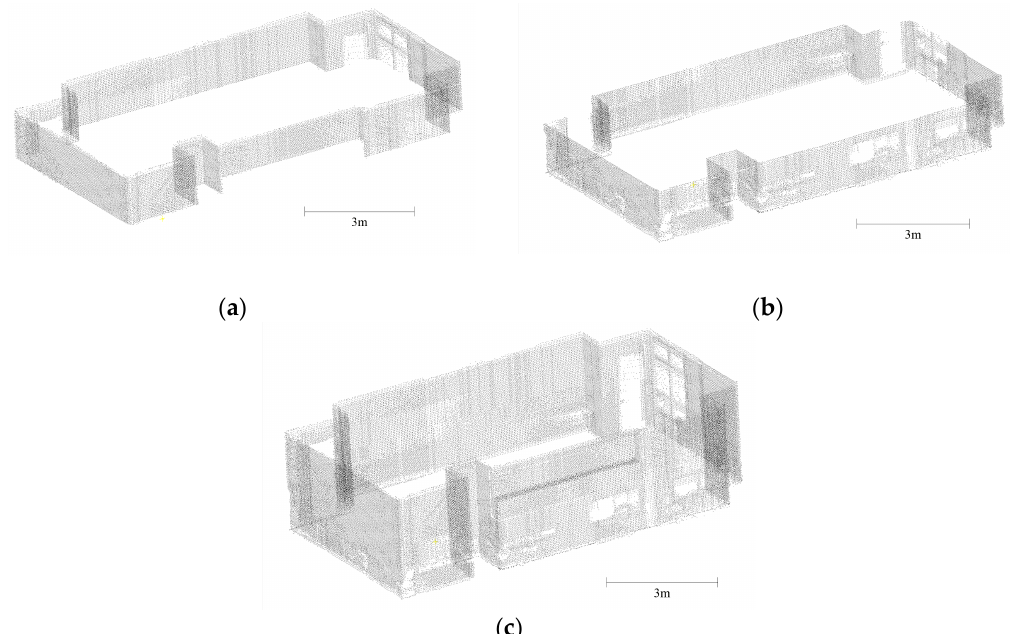
Figure 6. Analysis of detected wall segment: ( a ) wall segment above the slice height, ( b ) wall segment below the slice height, ( c ) final wall segment.